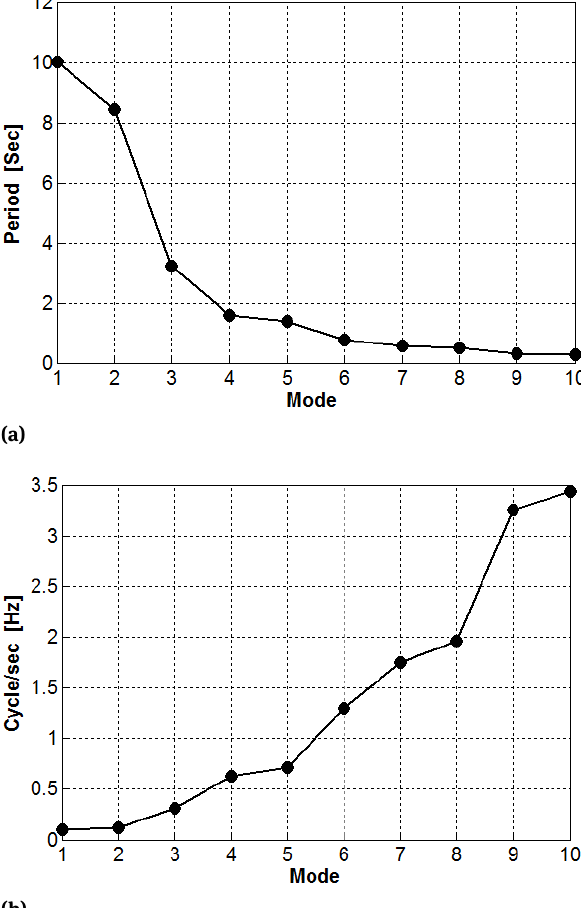
Figure 13: (a) The first ten periods of vibration of the structure; (b) The first ten frequencies of vibration of the